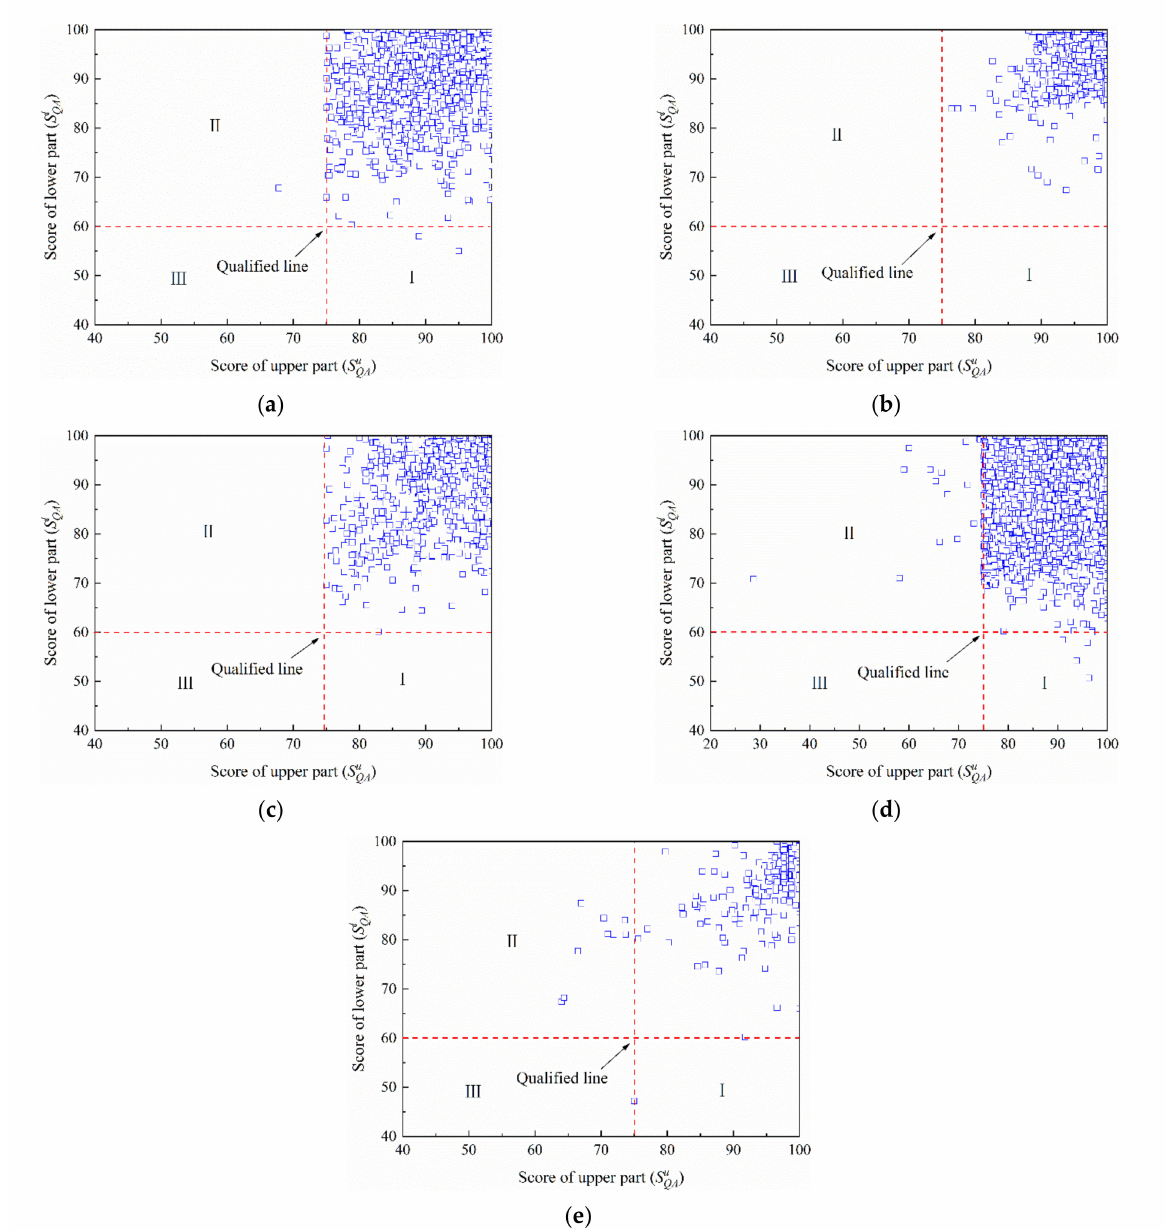
Figure 6. Score of DSM columns in: ( a ) littoral soft soil; ( b ) lagoon soft soil; ( c ) alluvial soft soil (Ancient Yellow River); ( d ) alluvial soft soil (Yangtze River); ( e ) lacustrine soft